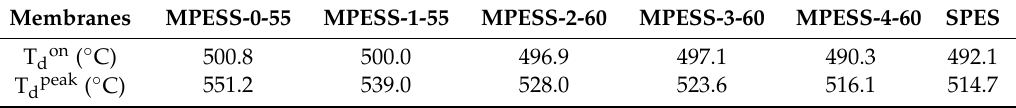
Table 3. Thermal decomposition temperature of the prepared PES/SPES membranes.